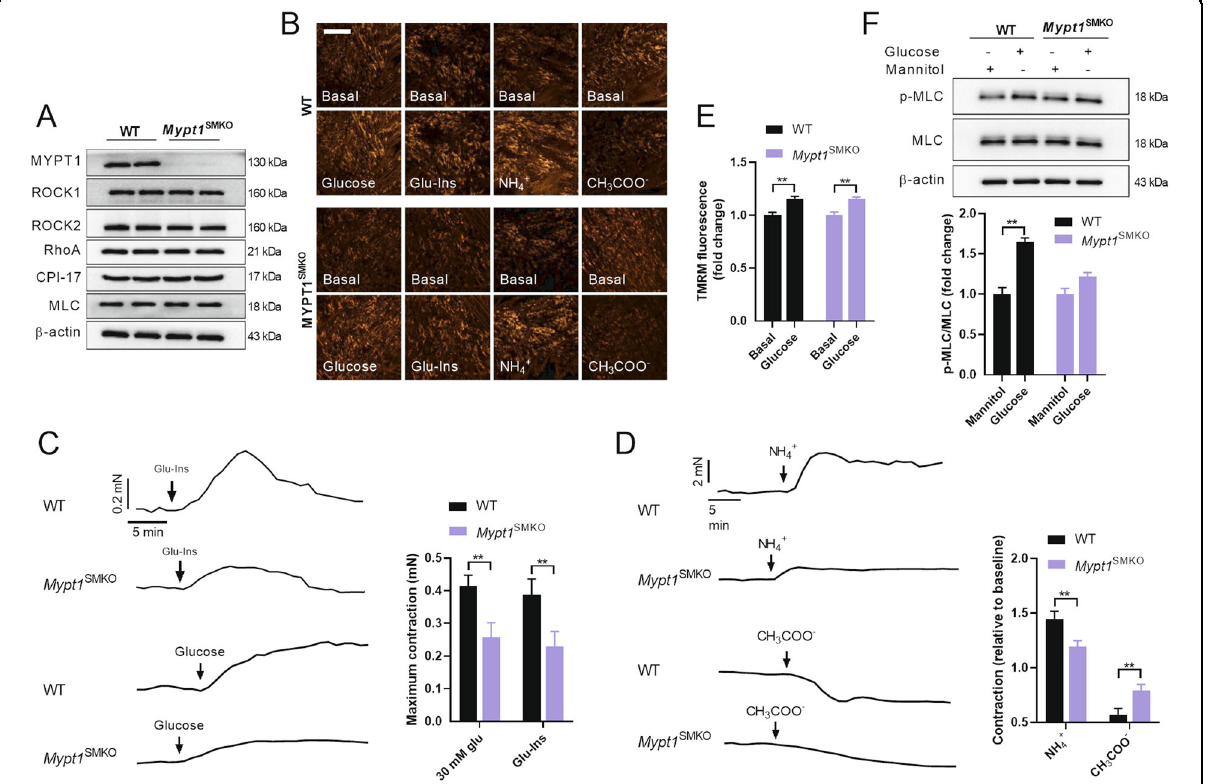
Fig. 5 Glucose-induced vascular constriction was impaired in Mypt1 SMKO mice. A Expressions of proteins in MLCP signaling in VSMCs isolated from WT and Mypt1 SMKO mice. B ΔΨ m in response to glucose (30 mM), Glu-Ins, NH 4 + , and Ch 3 COO - in VSMCs in isolated aortas from WT